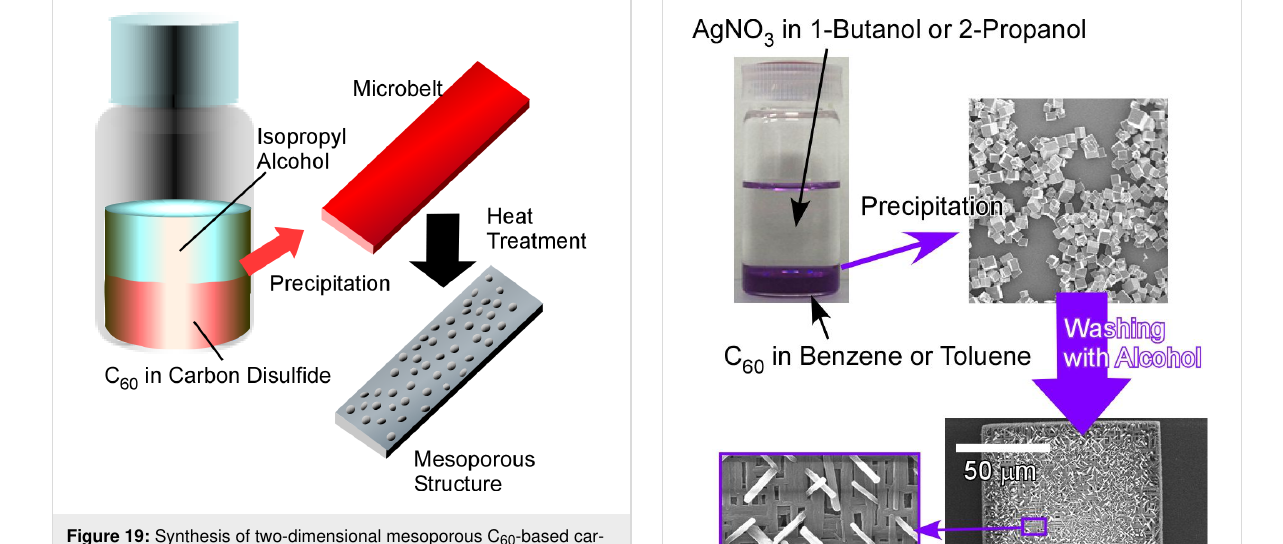
al. reported the synthesis of highly integrated three-dimen-